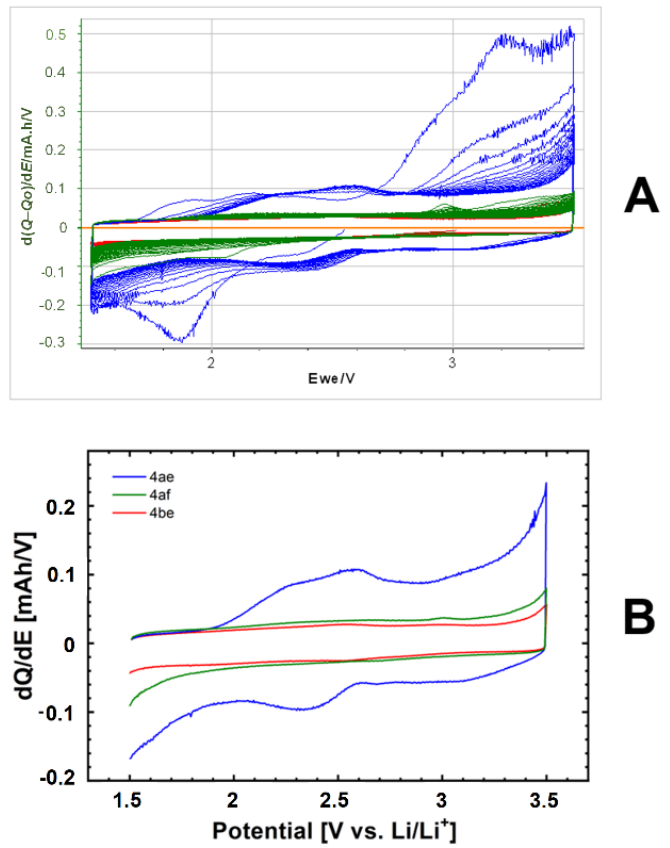
Figure 6. d Q /d E curves of compounds 4ae ( ▬ ), 4af ( ▬ ), and 4be ( ▬ ).( A ) and d Q /d E curves of compounds 4ae ( ▬ ), 4af ( ▬ ), and 4be ( ▬ ) after the 10th cycle ( B ).